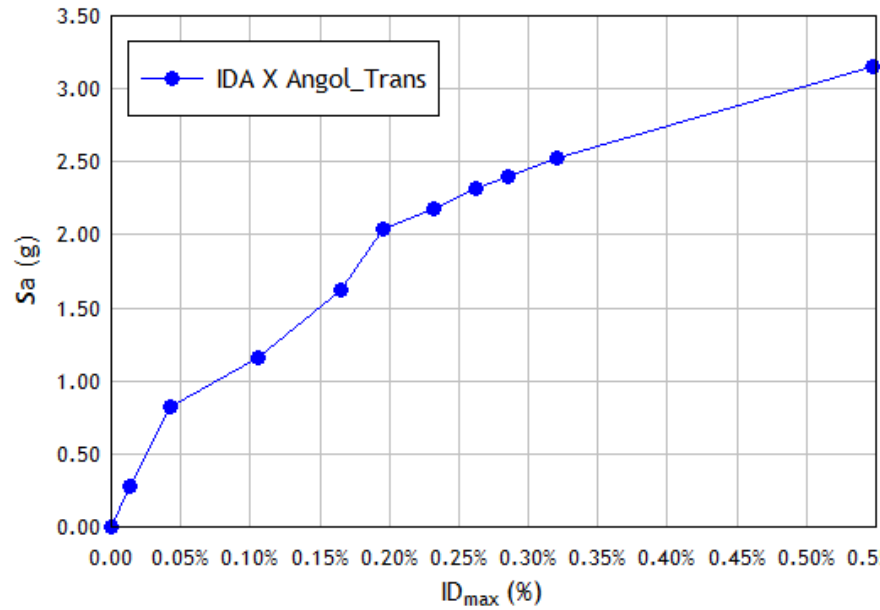
Figure 7. Alternative IDA curve in the X direction of the structural model, subjected to the transversal component of the seismic event recorded at Angol station.